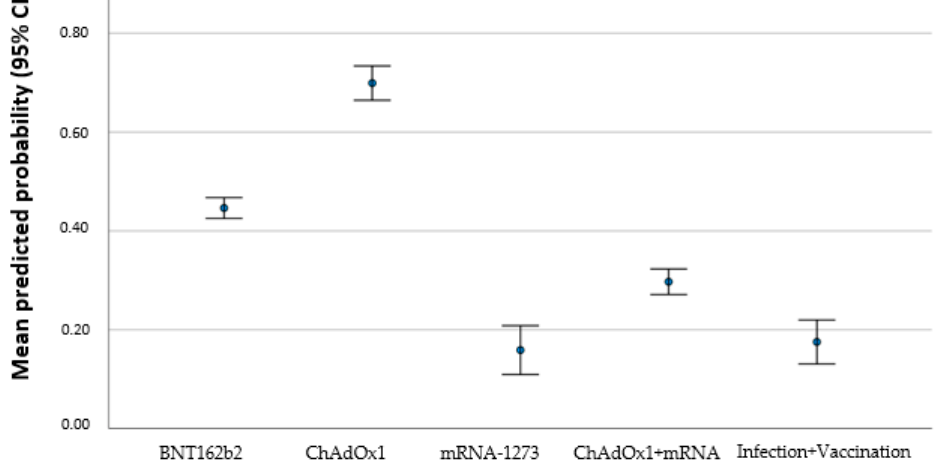
Figure 4. Mean predicted probability (95% CI) to achieve a threshold below 54 IU/mL according to different vaccines. BNT162b2 (Pfizer–BioNTech), mRNA -1273 (Moderna), and ChAdOx1 ( Astra- ing to different vaccines. BNT162b2 (Pfizer–BioNTech), mRNA ‑1273 (Moderna), and ChAdOx1 (As‑ Zeneca).